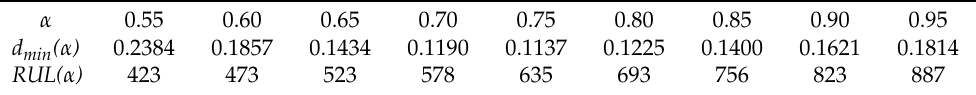
Figure 7. The ensemble method for RUL estimation of Bearing1-3 using Bearing1-1. Table 1. Similarity evaluation for RUL estimation between Beaing1-3 and